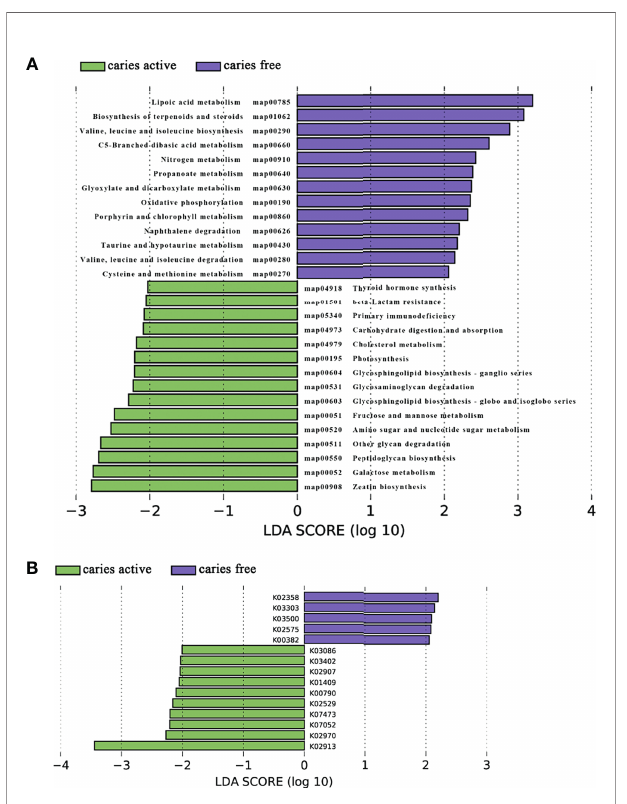
FIGURE 5 | Linear discriminant analysis (LDA) effect size analysis (LEFSe) was used to identify level 3 pathways (A) and KOs (B) with signi fi cant differences in relative abundance between the caries active and caries-free groups.